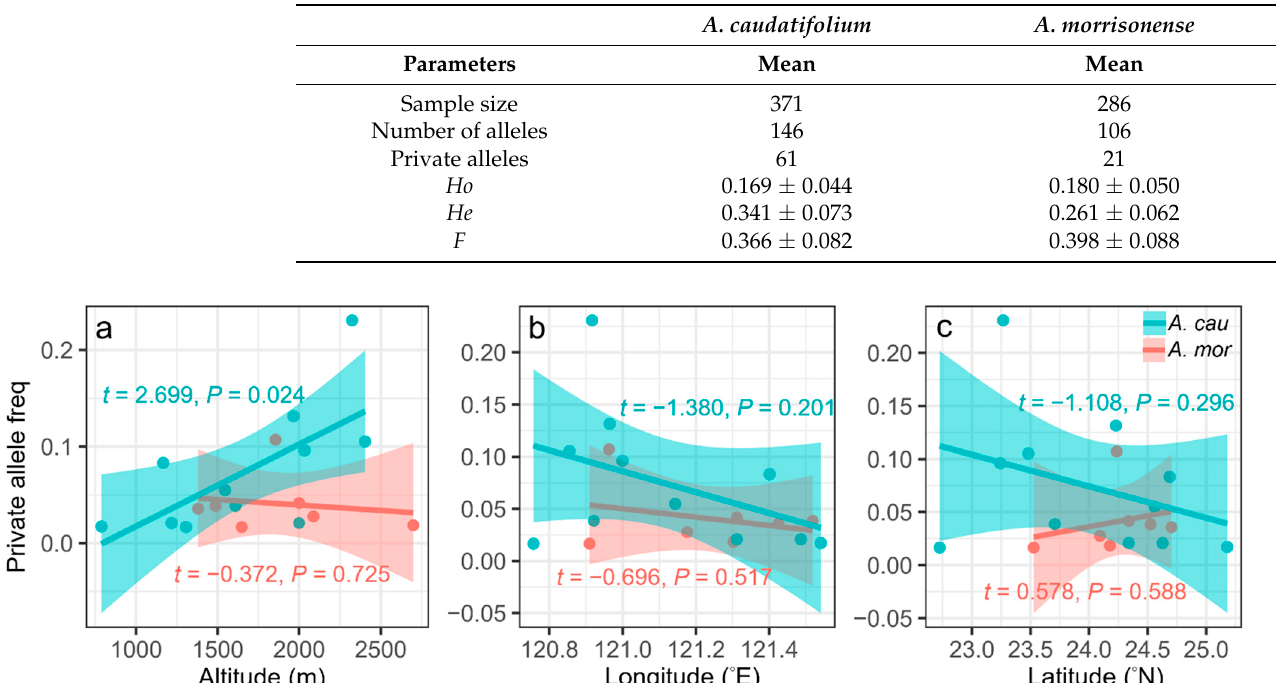
Table S3. The pairwise F ST among populations between the two species ranges 0.249–0.718. The average pairwise F ST among populations of A. caudatifolium ( F ST = 0.144) is higher than Table 1. Summary results of the estimated genetic diversity of Acer caudatifolium and A. morrisonense .